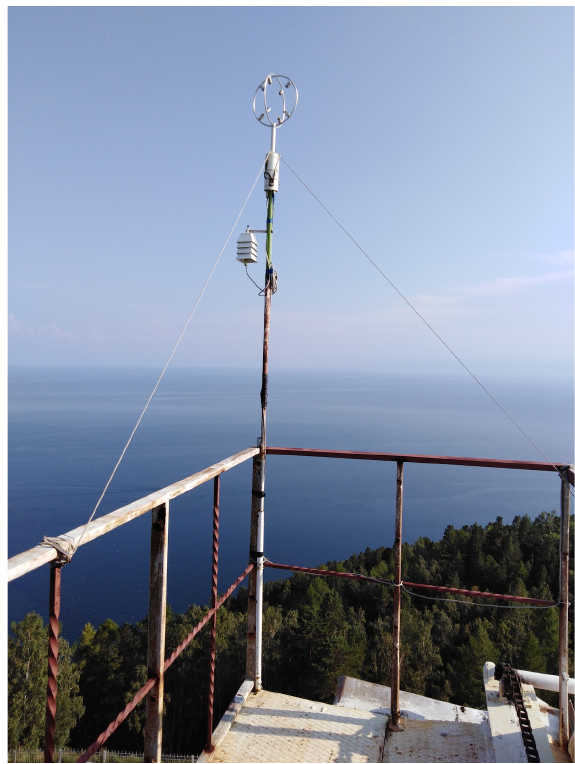
Figure 1. Meteorological sensor mounted on the mast, large solar vacuum telescope.